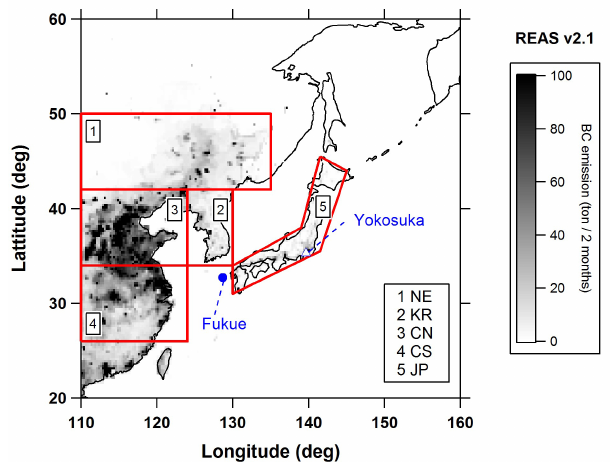
Figure 1. Map of the investigated region with two observation sites (Yokosuka – open triangle; Fukue Island – closed circle) and five defined areas (1 – Northeast China; 2 – Korea; 3 – Central North China; 4 – Central South China; 5 – Japan). The bimonthly mean BC emission rate (March–April) in 2008 is overlaid on the map (REAS ver. 2.1, Kurokawa et al.,